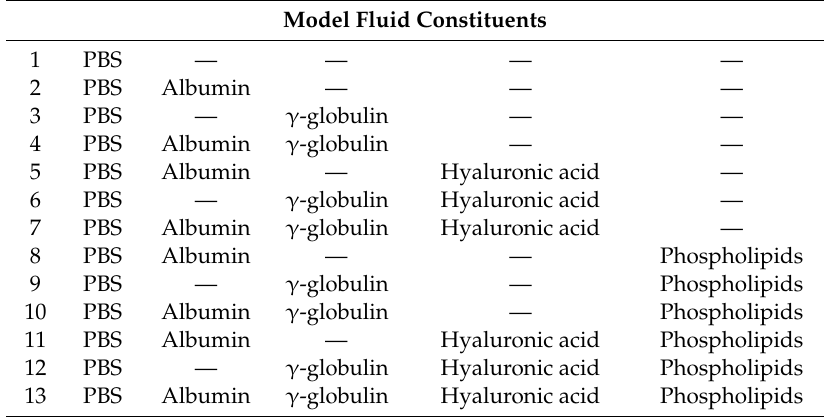
Table 1. The combinations of the constituents in the lubricants.